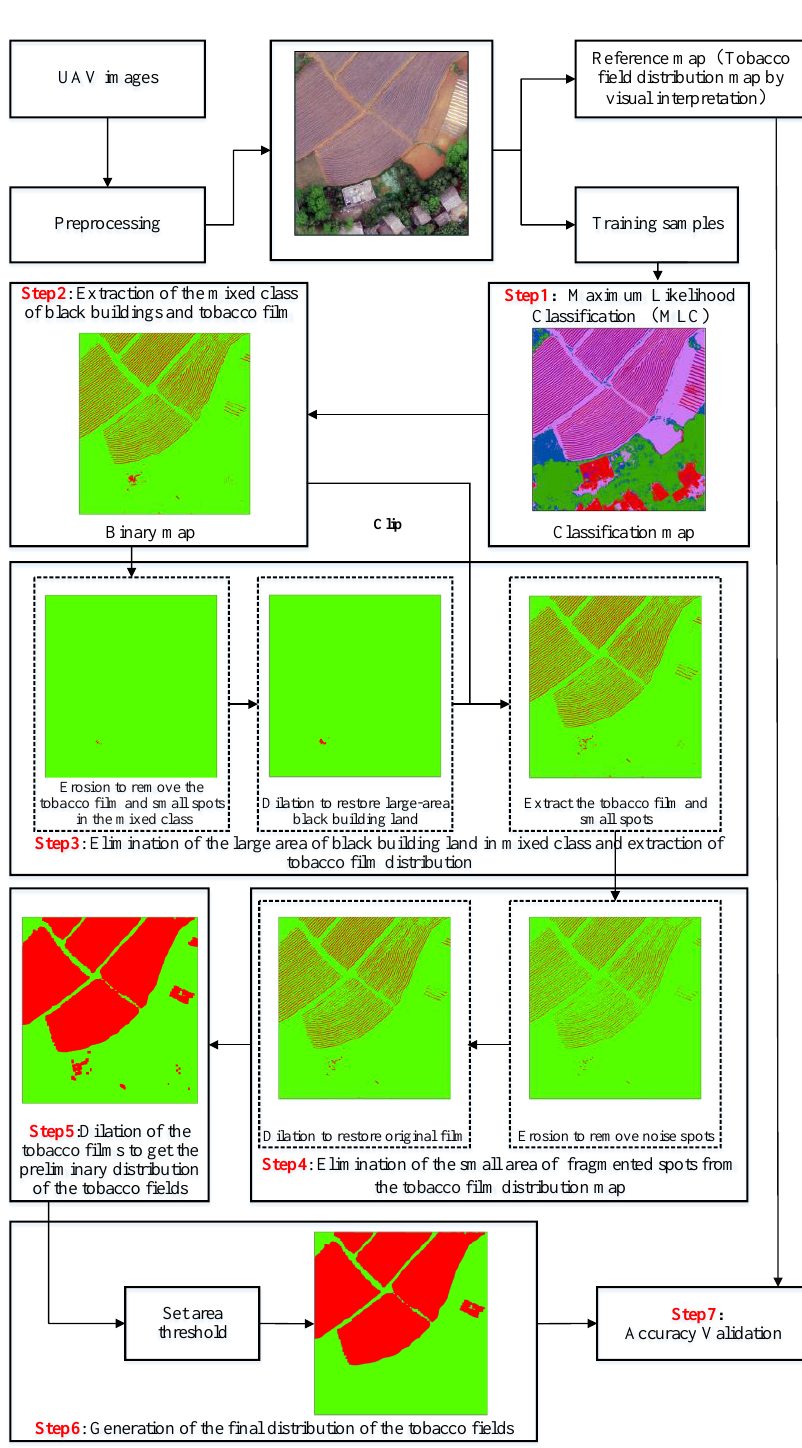
Figure 4. Technology flowchart.